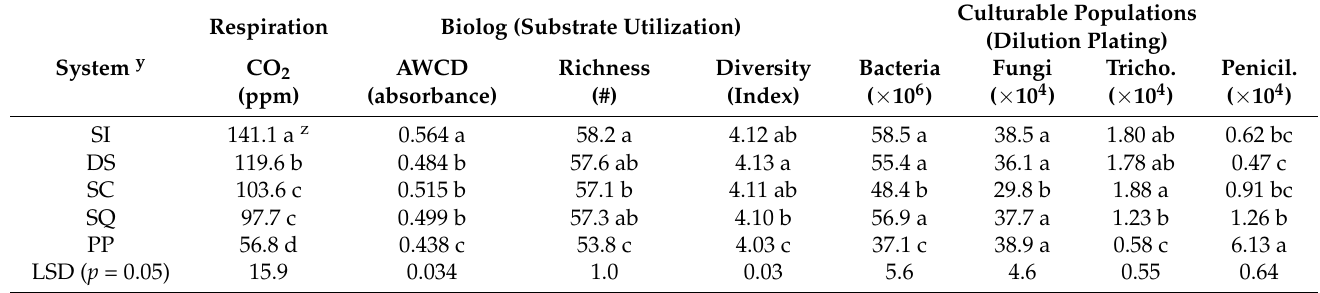
Table 9. Effect of different cropping systems on selected soil biological properties, including microbial activity represented by CO 2 respiration and substrate utilization, and culturable populations of select microorganism groups from combined data over three cropping seasons